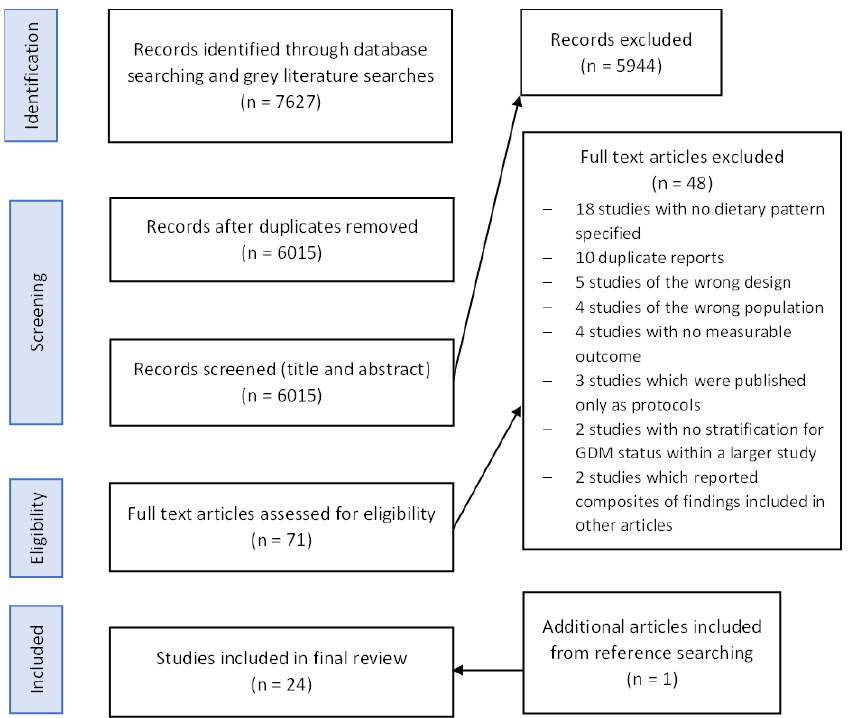
Figure 1 . PRISMA flow diagram of identification, screening, eligibility, and inclusion of articles within the scoping review.